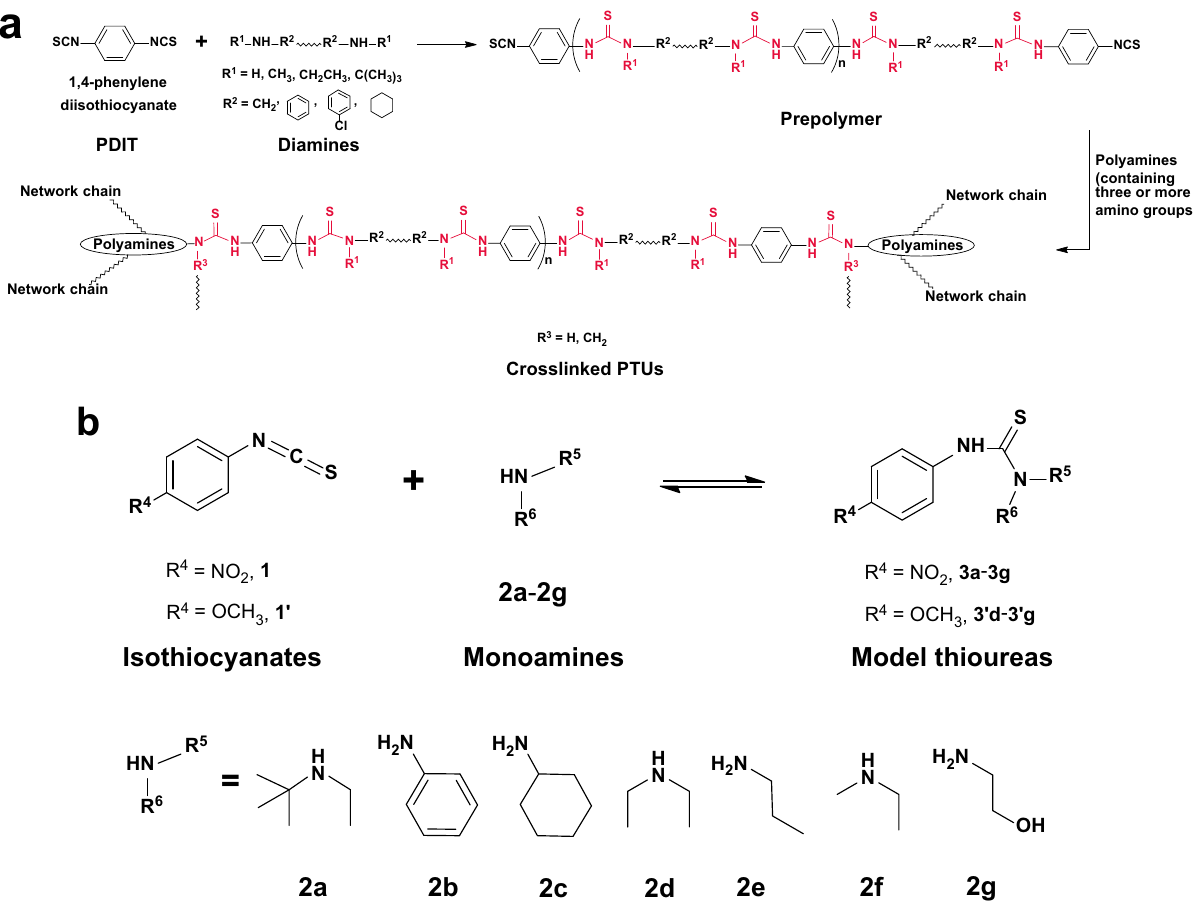
Fig. 1 Design of polythiourea networks. a Synthesis of crosslinked PTUs containing thioureas. b Dissociation/association equilibriums of thioureas, and chemical structures of commercial isothiocyanates and